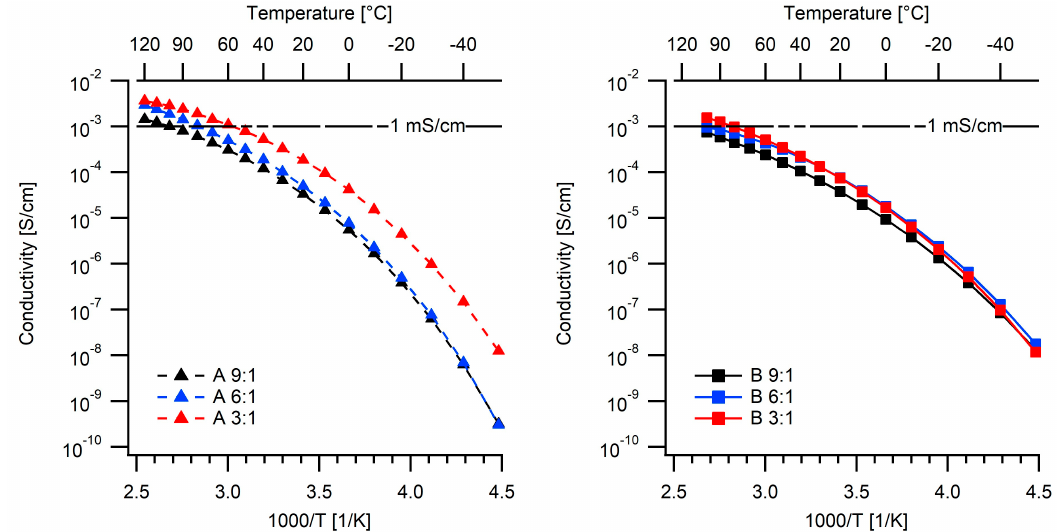
Figure 4. Ionic conductivity cooling traces.